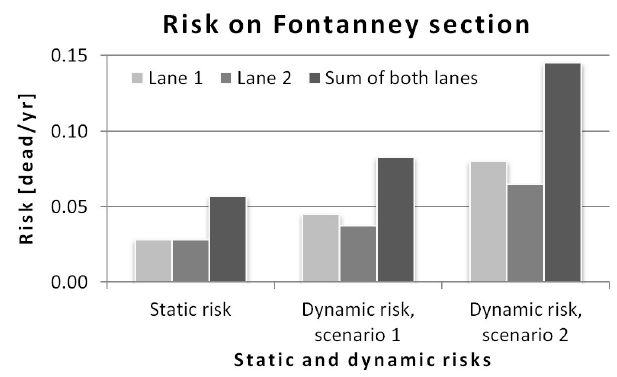
Fig. B3. Risk results on Pillon